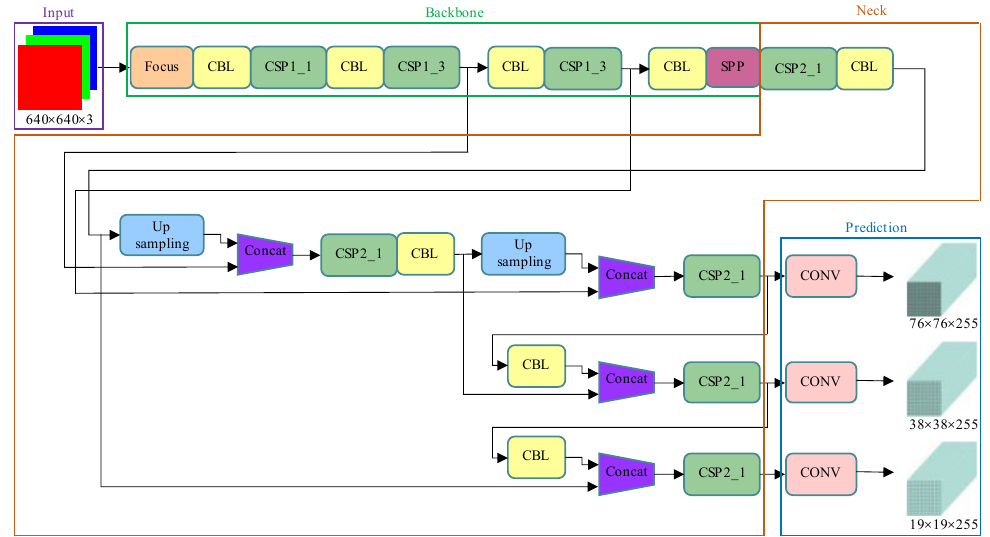
Figure 5. YoloV5 network structure.